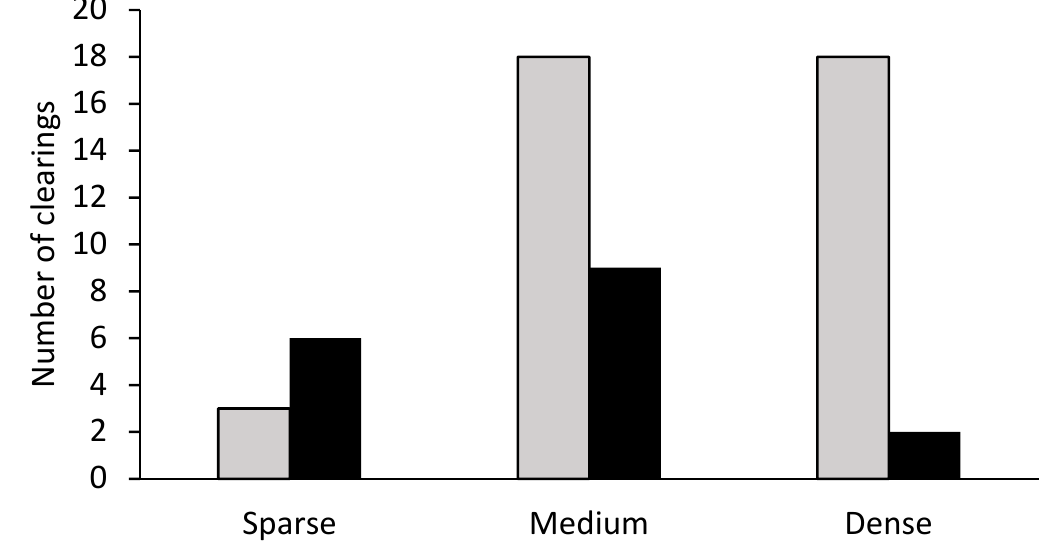
Figure 3. Number of unoccupied clearings (grey columns) and Nightjar territories (black columns) in three categories of undergrowth vegetation.